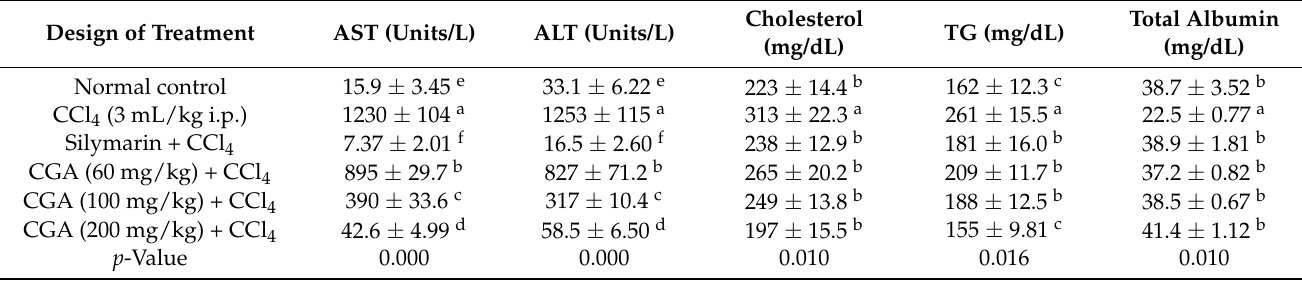
Table 1. Effects of CGA on serum AST, ALT, cholesterol, and TG in CCl 4 intoxicated